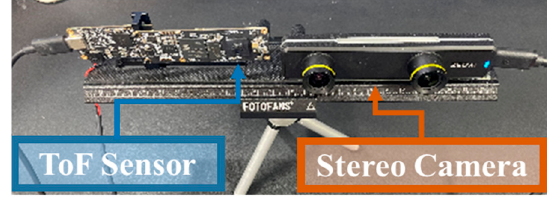
Figure 2. ToF-stereo fusion test configuration.